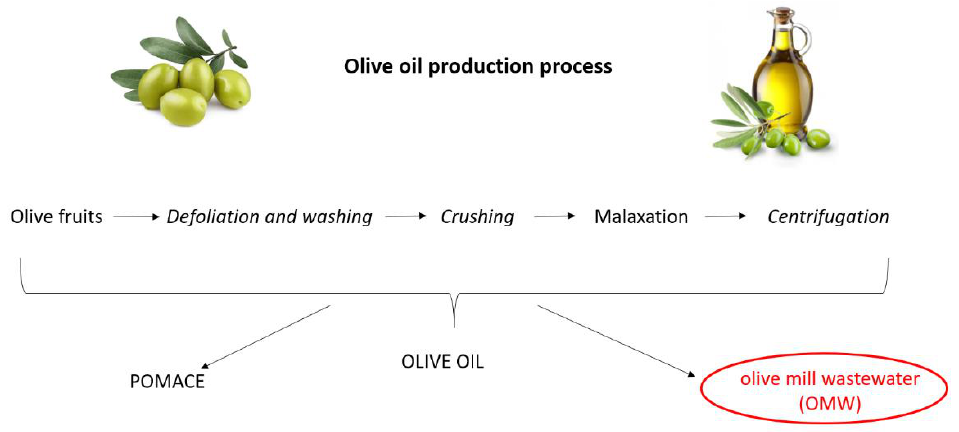
Figure 1. Olive oil production process.